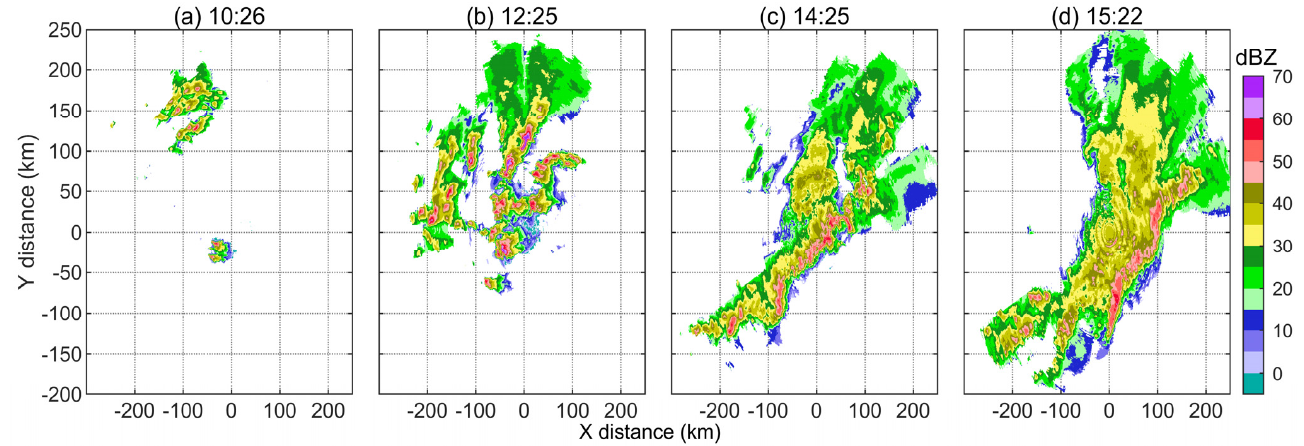
Figure 8. CAPPI at 3 km height observed by Z9532 radar on 17 May 2020. X and Y represent west–east and south–north distances relative to the radar site. ( a ) 10:26; ( b ) 12:25; ( c ) 14:25; ( d ) 16:59. The time is in UTC.